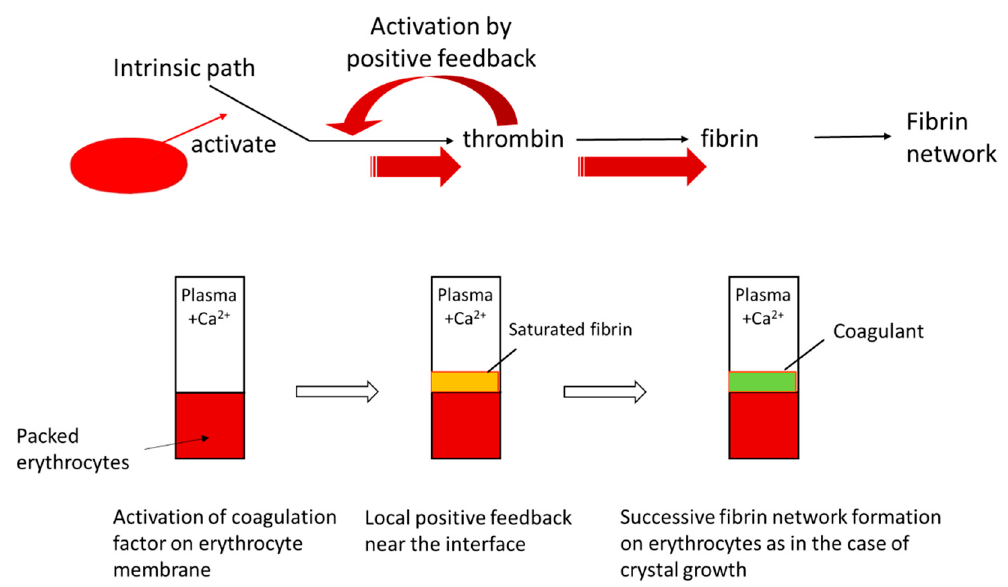
Figure 7. Scheme of coagulation induced by contact of plasma with packed erythrocytes.